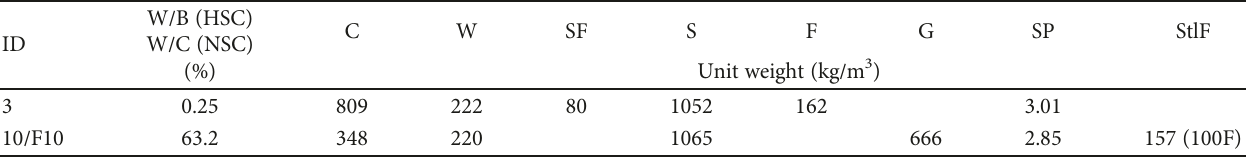
Table 2: Mix proportions of concrete.